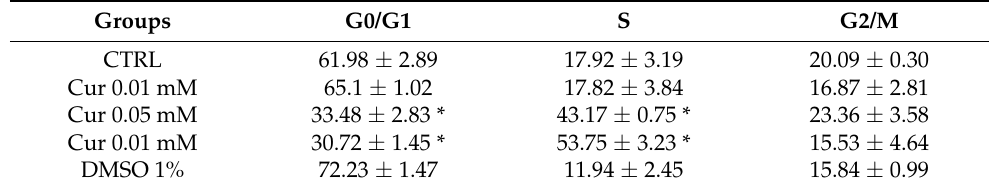
Table 2. In the table is reported the mean ± SE. Values represents the percentage of cells in each phase of the cell cycle. * Significance of statistical analysis performed through one-way ANOVA followed by Tukey test. p < 0.001 in all the groups marked with * versus CTRL. The percentage of cells distributed in cell cycle phases of all the vehicles are reported in supplementary Table S2.